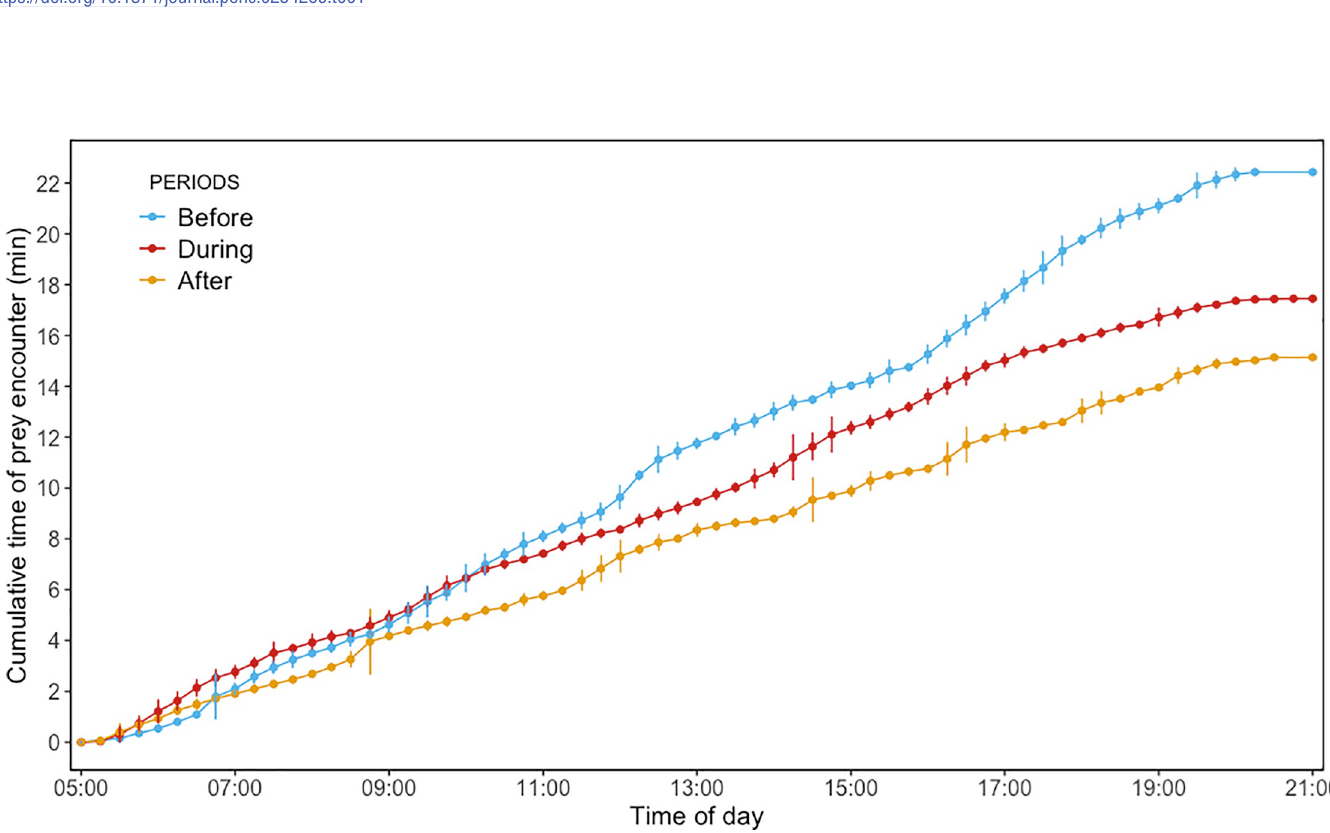
Fig 3. The cumulative time of prey encounter of little penguins as a function of the time of day for the three stages. Blue, red and yellow curves correspond to "Before", "During" and "After" stages,